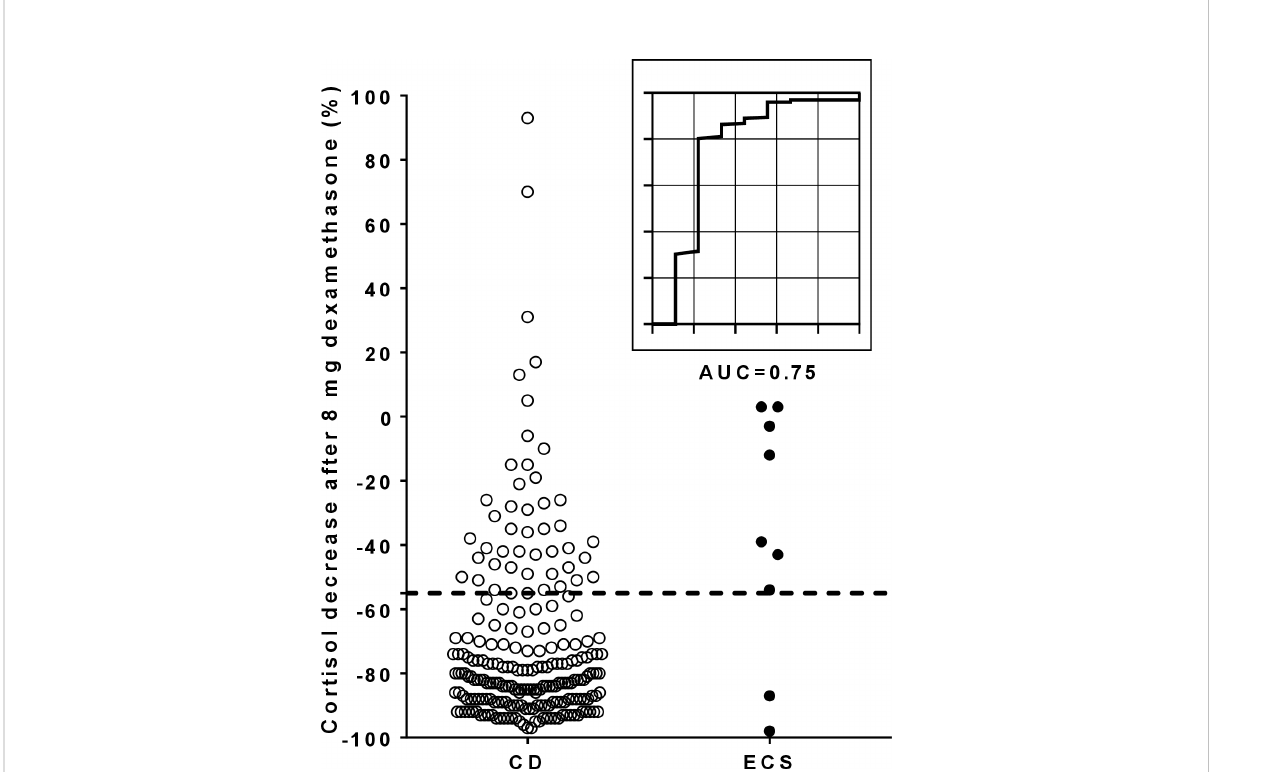
FIGURE 4 Individual %-suppression of cortisol after dexamethasone and corresponding ROC curve for the overnight 8 mg dexamethasone suppression test. The dotted line in the scatter plot illustrates the optimal cut-off of 55% for the %-suppression of cortisol after dexamethasone. One CD patient with an outlier result of 628% is not reported in the scatter plot. AUC, area under the curve; CD, Cushing ’ s disease; ECS, ectopic Cushing ’ s syndrome; ROC, receiver operating characteristic.